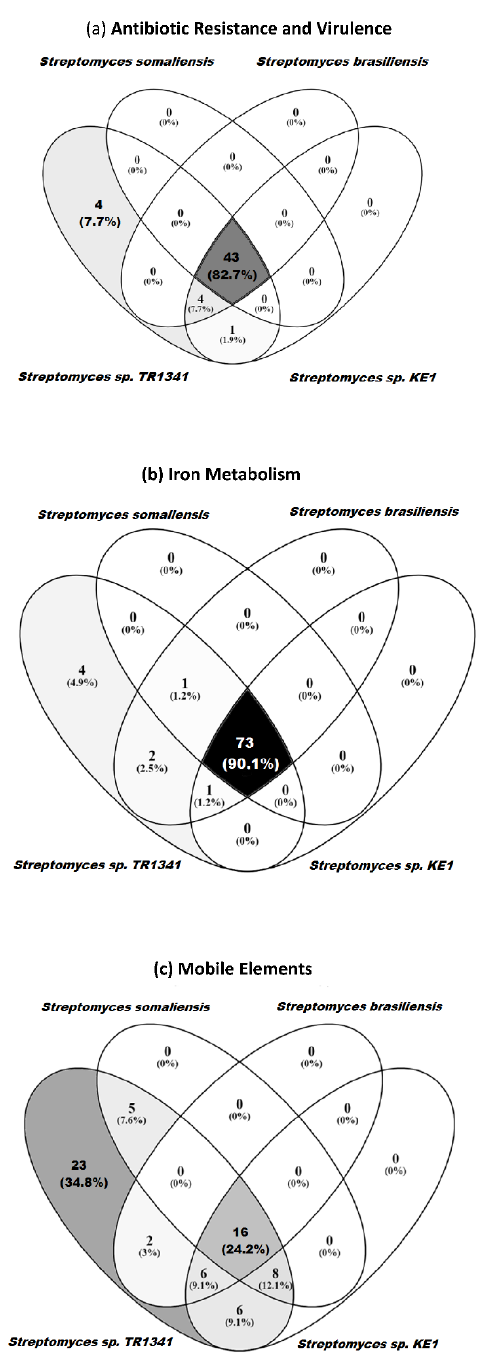
Figure 7. Genes shared between Streptomyces sp. TR1341 and the human-associated Streptomyces species in the following RAST categories: ( a ) proteins associated with antibiotic resistance and virulence factors; ( b ) proteins associated with iron metabolism; ( c ) mobile elements (associated to secondary metabolism but no other